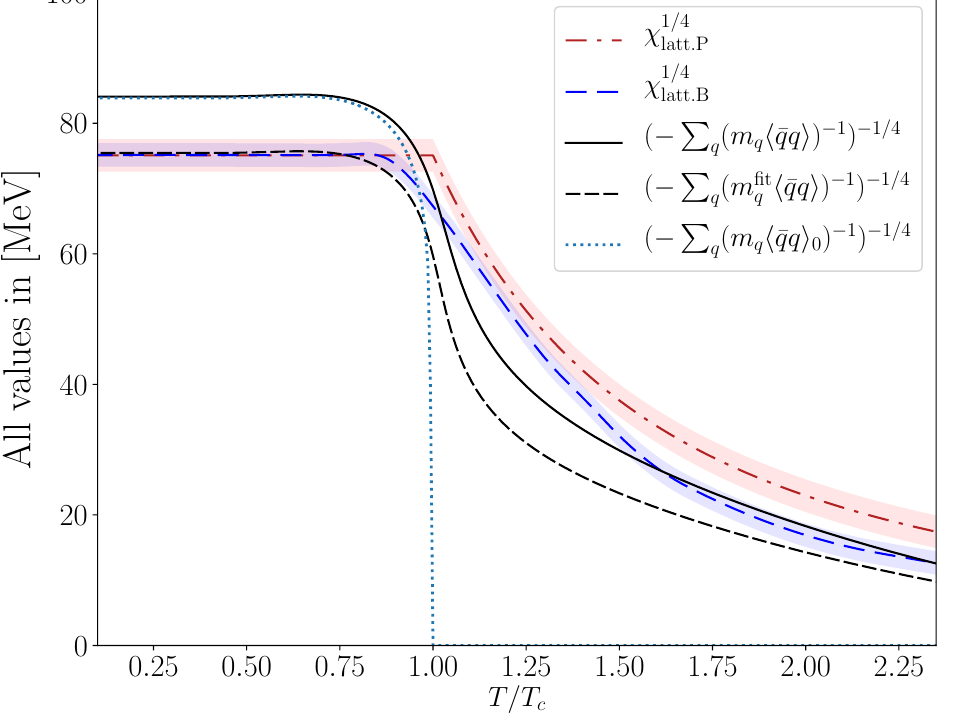
= 6.56 MeV, while d